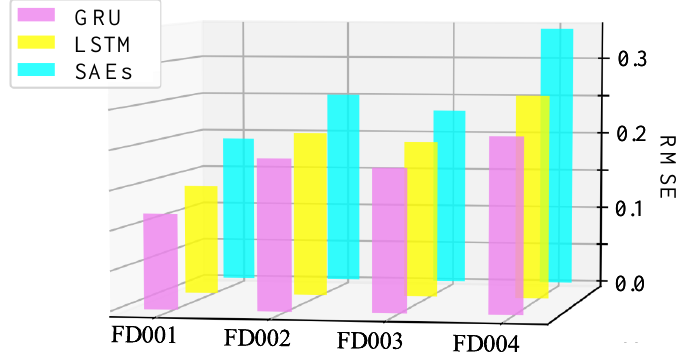
Figure 8. The values of RMSE and scores of stacked autoencoders (SAEs), long short term memory network (LSTM) and GRU from four sub datasets are on the chart. The differences are plotted in the